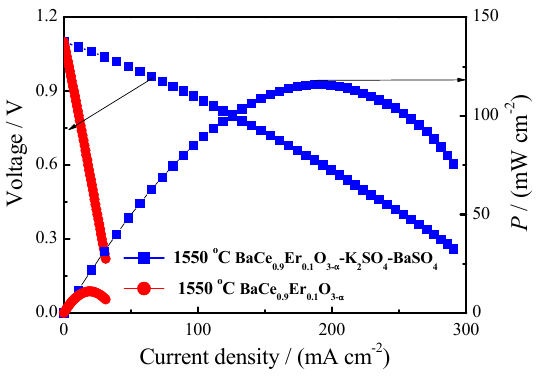
Figure 7. Hydrogen/oxygen fuel cells assembled with BaCe 0.9 Er 0.1 O 3- α and BaCe 0.9 Er 0.1 O 3 −α –K 2 SO 4 – BaSO 4 as supporting electrolytes at 700 °C.